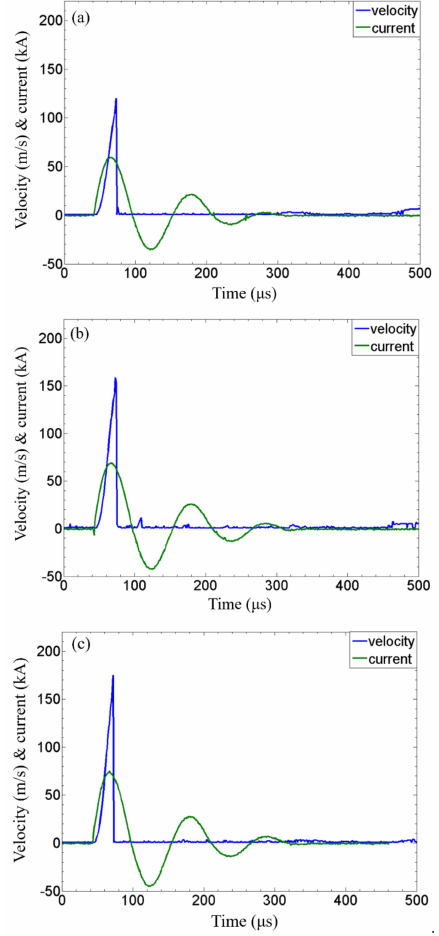
Figure 9. The primary current of a uniform pressure actuator and the flyer velocity of Cu110 sheets at capacitor bank energies of ( a ) 1.6 kJ, ( b ) 2.4 kJ, and ( c ) 2.8